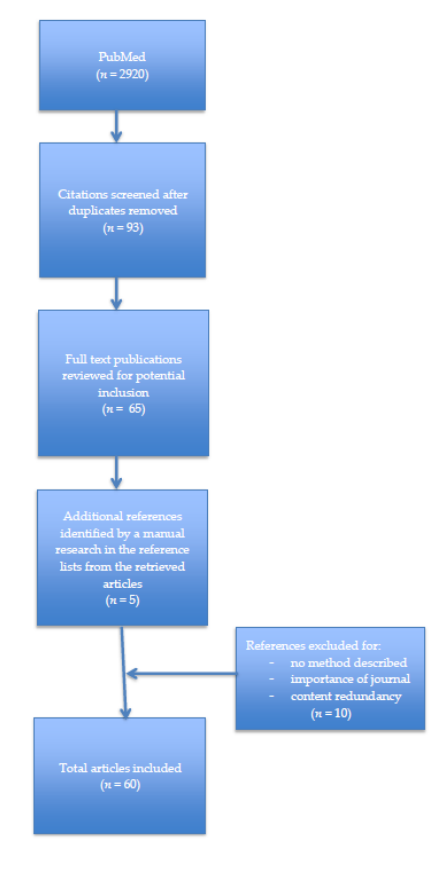
Figure 1. Flowchart of selection process.